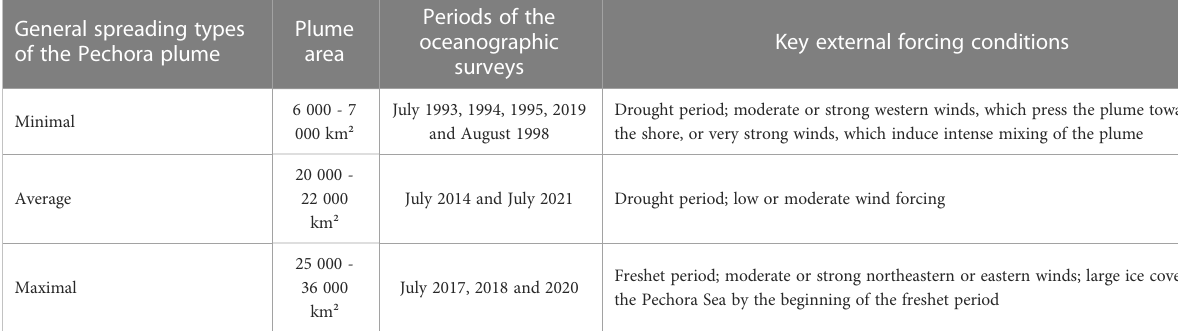
TABLE 2 Main information about general spreading types of the Pechora